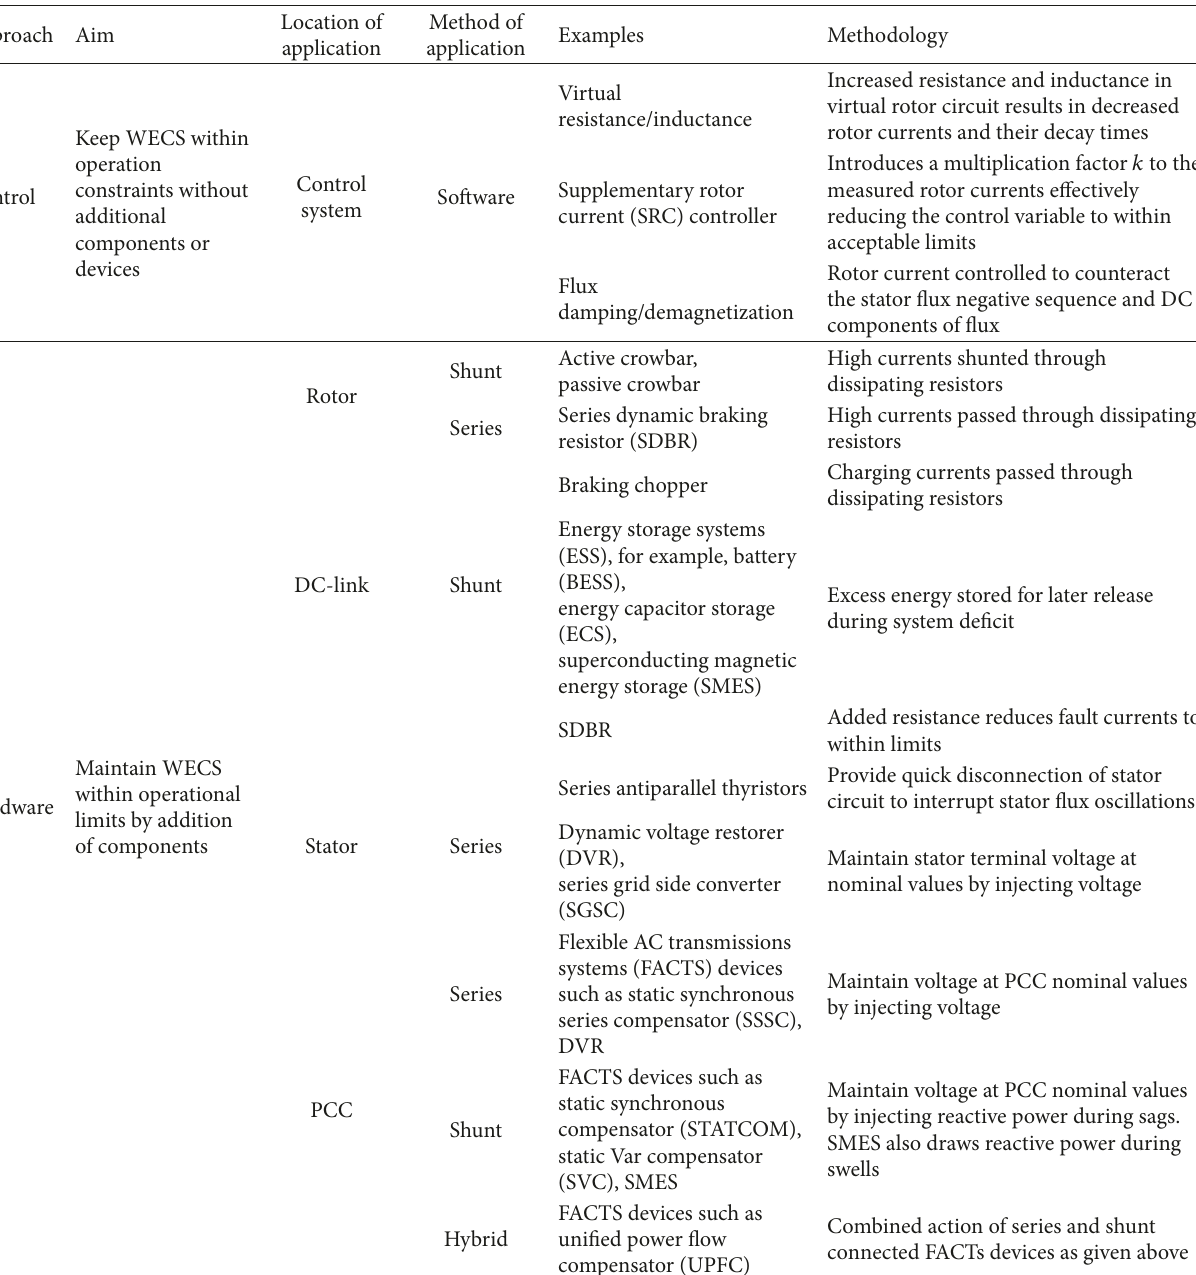
Table 2: DFIG WECS proposed solutions to faults from grid